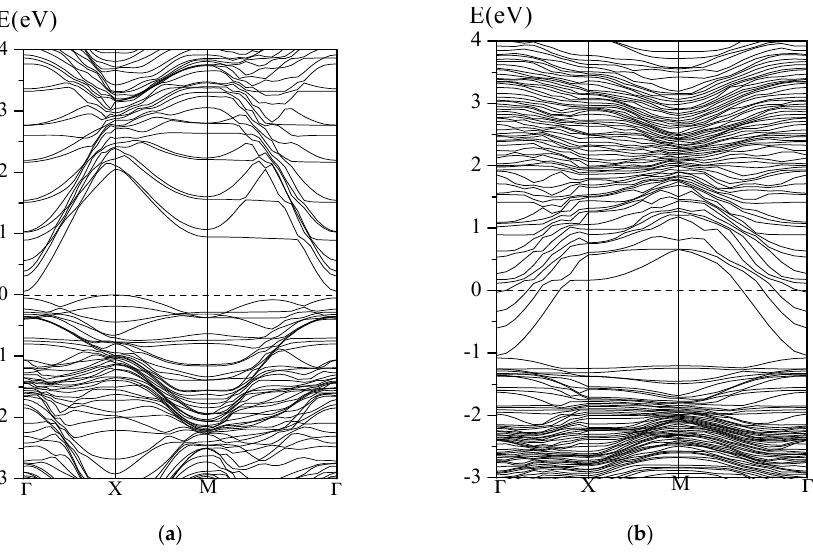
Figure 5. Band structures of the ( a ) perfect and ( b ) defective WO 3 (001) surface. In the case of CO oxidation on the WO 3 (001) surface which is modified by pre-adsorbed oxygen, both oxygen species on this surface, namely the top oxygen and the oxygens belonging to the O 2 − group may react with the CO molecule. The corresponding optimized structures have been given in Figure 4b,c, respectively. Similar to a perfect surface, when CO reacts with the lattice oxygen (O t ), the CO 2 product is generated and a new oxygen vacancy is created, while for the case of the O 2 − group, one O atom of the active oxygen species transfers to CO and the CO 2 product is physically adsorbed on the surface. It is interesting that after releasing CO 2 molecule, the perfect WO 3 (001) surface is reproduced since one oxygen atom occupies the vacancy site. Contrasting the total energies of these two systems, the latter is about 2.93 eV more stable than the former. Hence, CO tends to react with the active oxygen species O 2 − for the O 2 pre-adsorbed WO 3 (001) surface, which is in conformity with